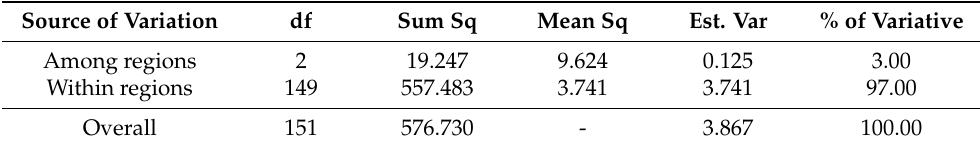
Table 3. Results of the analysis of molecular variance (AMOVA).